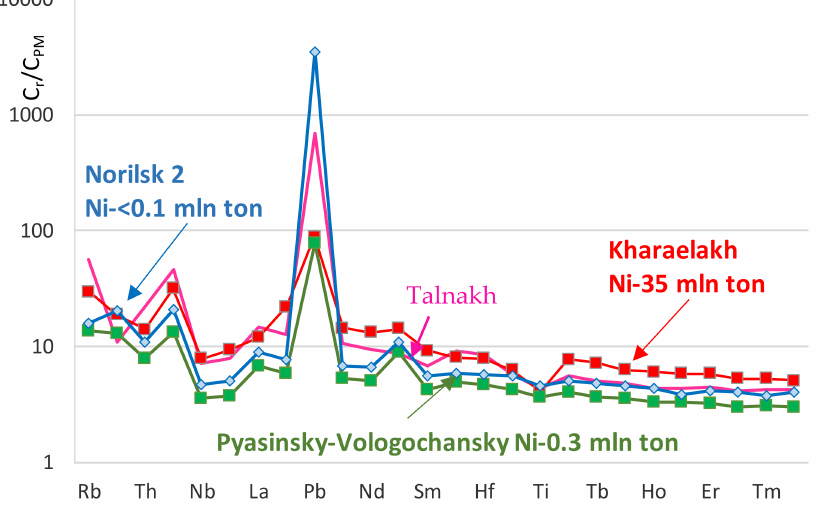
Figure 13. Spider diagrams for the average mean compositions of the intrusive rocks in the Norilsk area (normalized to primitive mantle, after